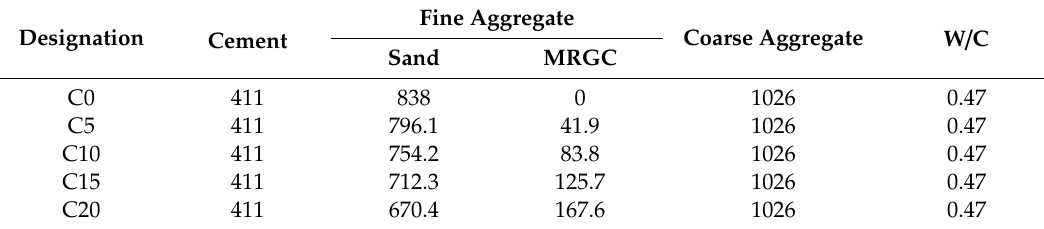
Table 2. Concrete mix proportions (kg / m 3 ).